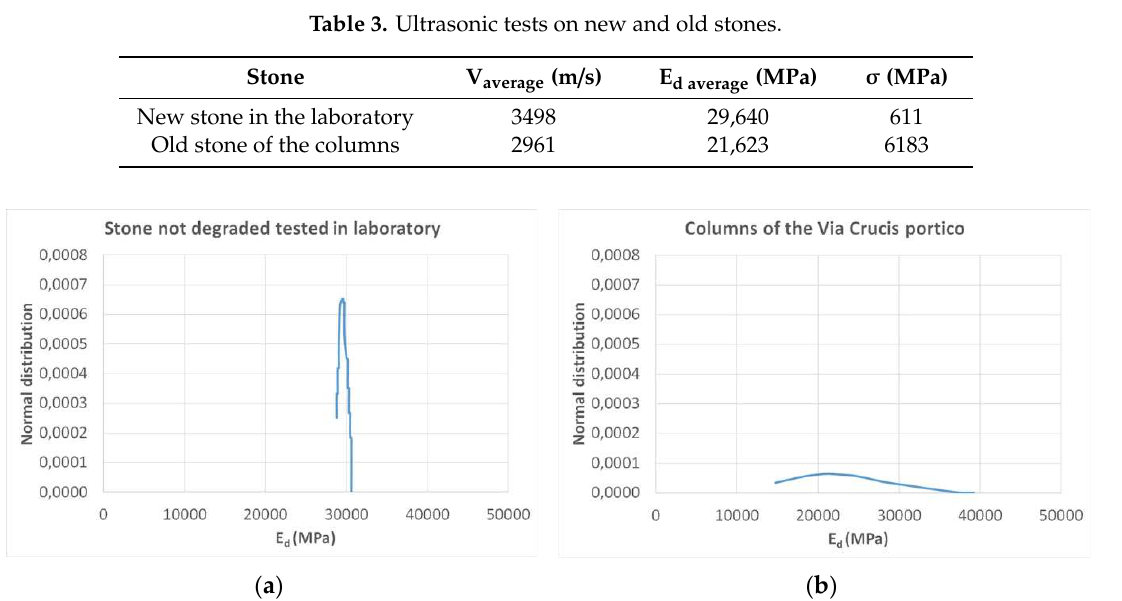
Figure 11. Gaussian distribution E d of non-degraded stone (a) and of the same type of stone degraded in the columns of the Via Crucis portico at Ghiffa (b) . Table 3. Ultrasonic tests on new and old stones.